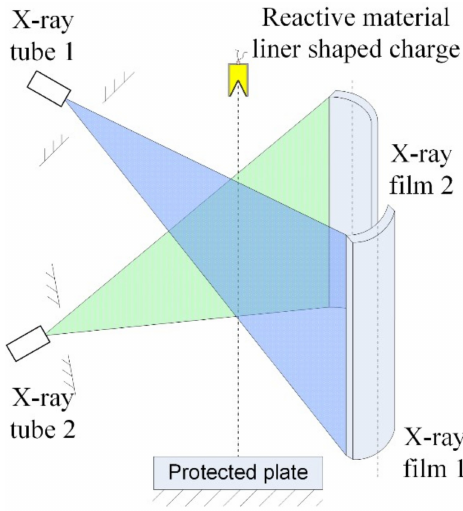
Figure 4. Experimental principle of